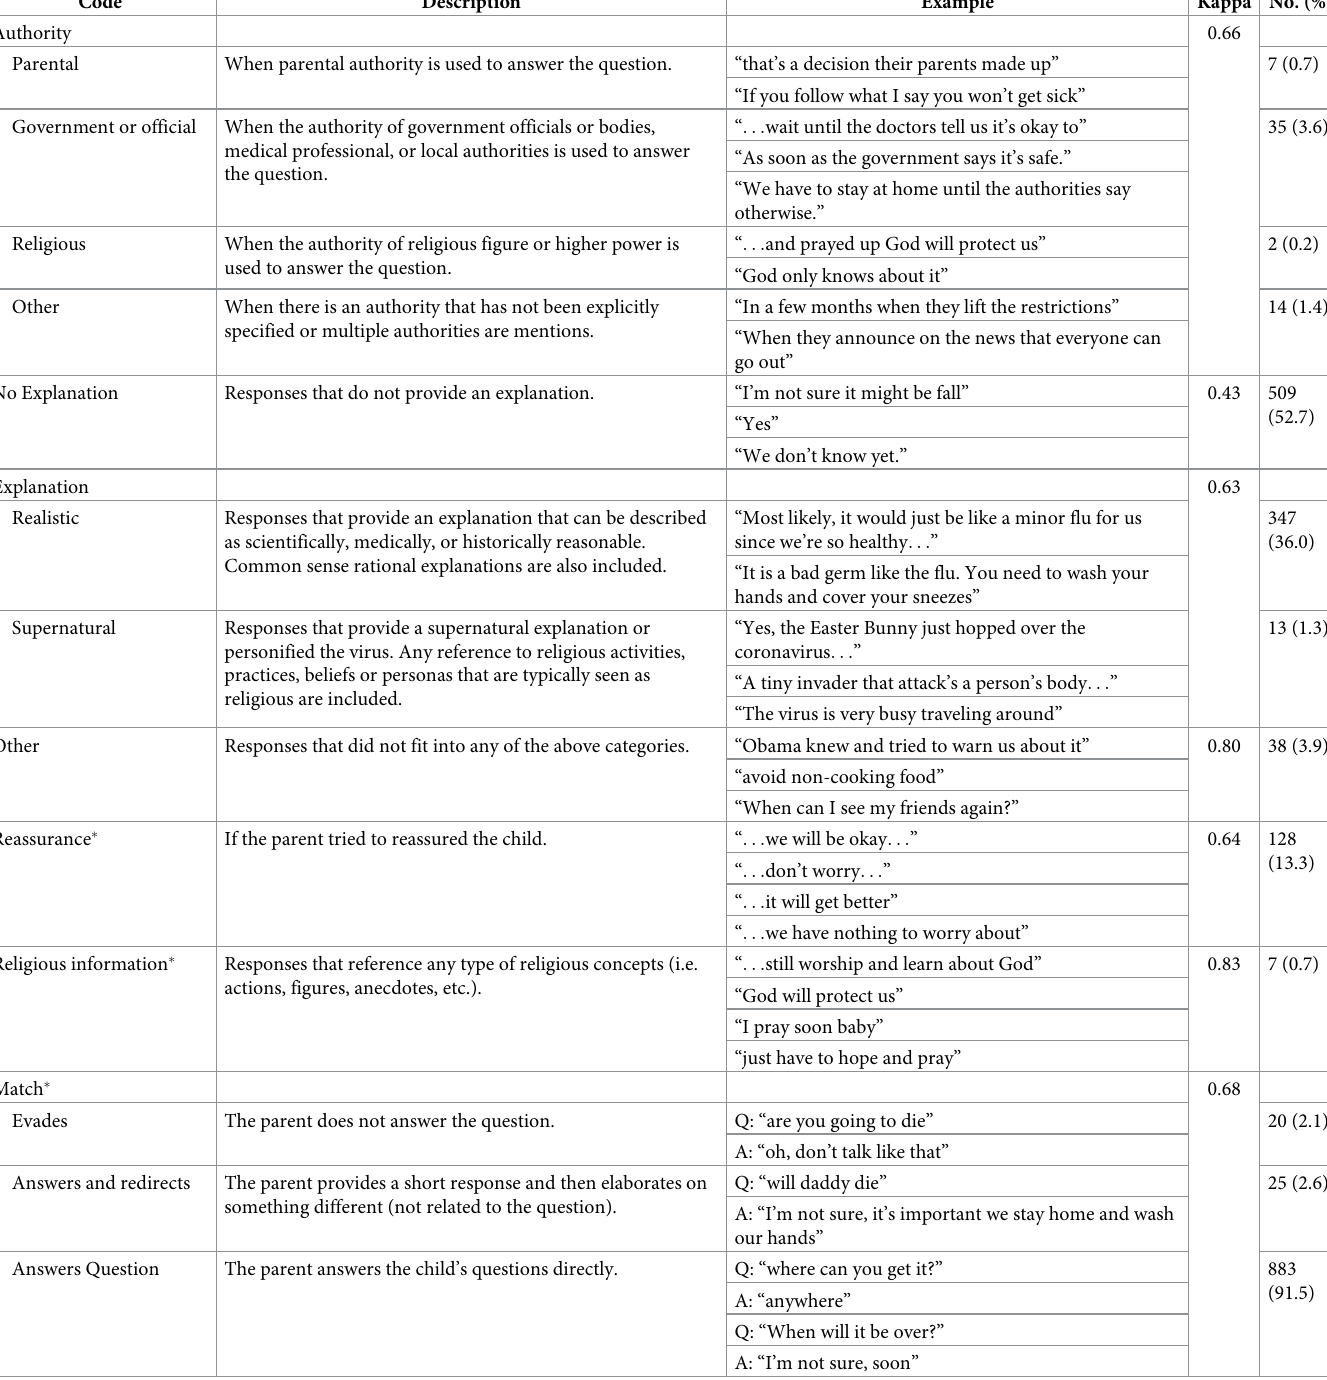
Table 4. Coding of parent’s responses to reported